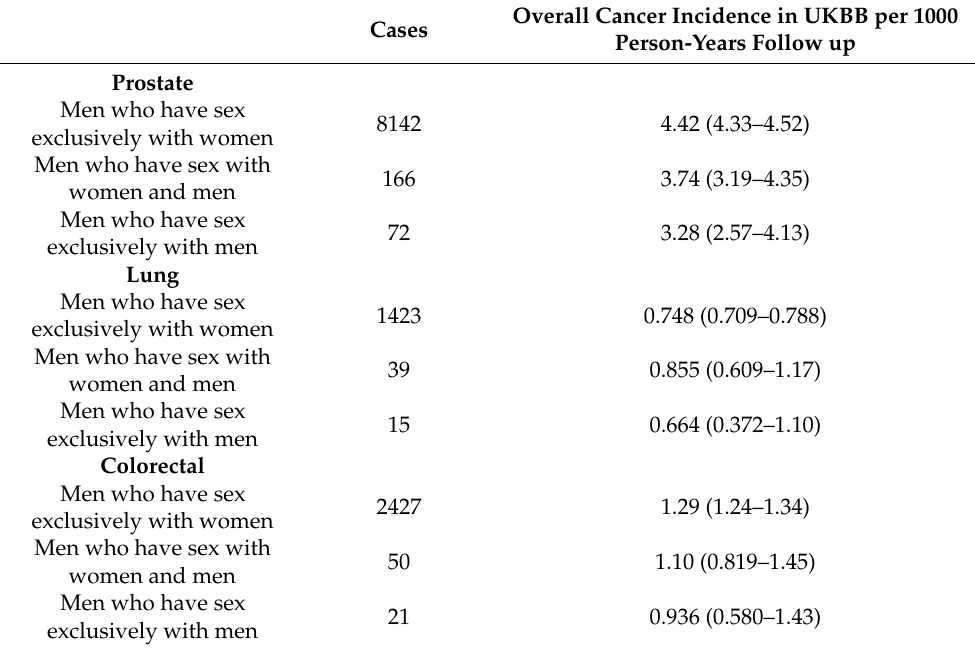
Table 3. Incident cancer case numbers, and incidence rates in men, stratified by sexual history.